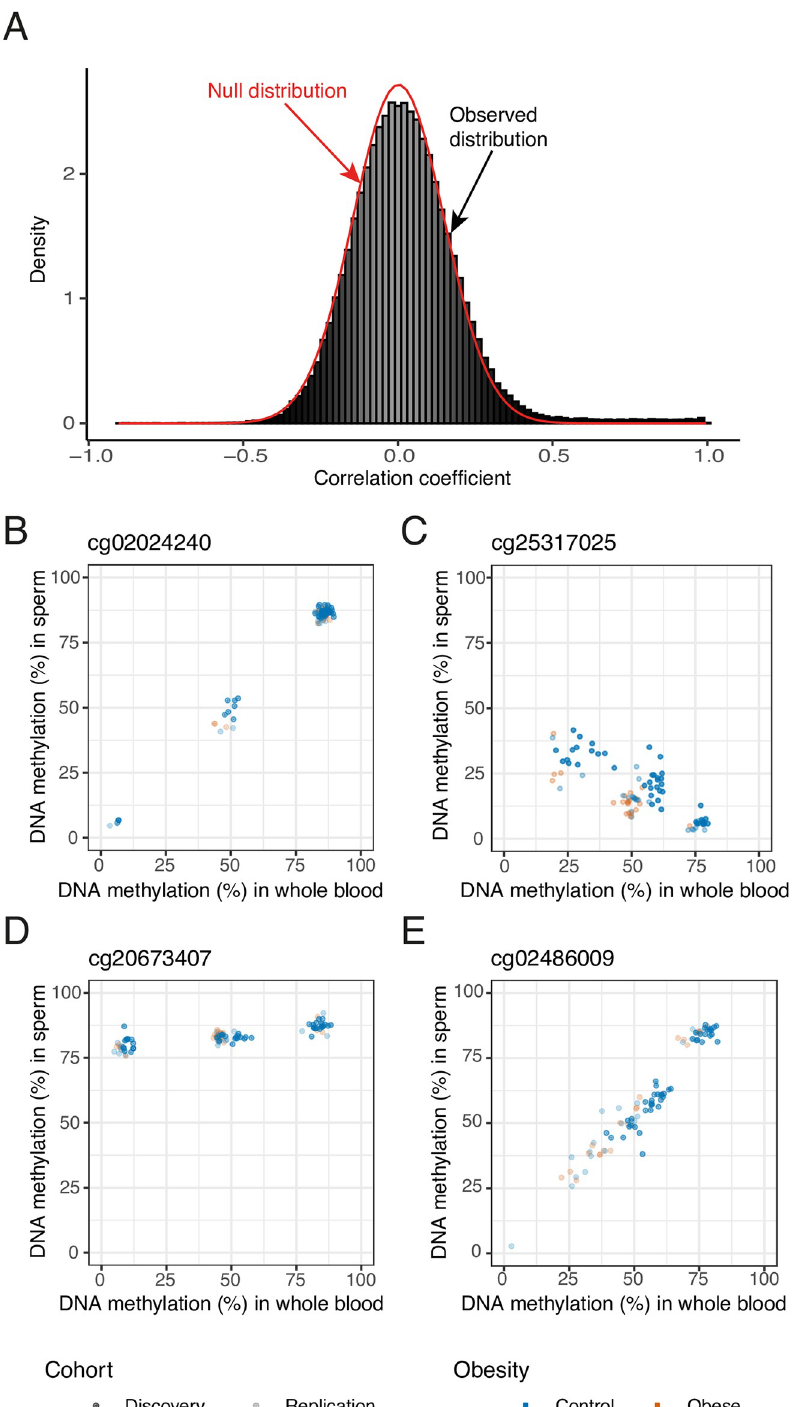
Fig 4. Covariation of DNA methylation between blood and sperm. ( A ) The observed correlation of DNA methylation levels in sperm and blood (histogram) is plotted against the estimated null distribution (red density curve). A small percentage of sites display highly correlated DNA methylation levels ( r > 0.8), and the observed distribution is overall slightly shifted to the right compared to the null distribution. ( B ) cg02024240 (chr5:159669974) shows a strong DNA methylation correlation between blood and sperm and a trimodal methylation pattern suggestive of a genetically driven effect ( r > 0.99, P = 4.68 × 10 − 48 ). ( C ) cg25317025 (chr18:47019823) is one of 30 sites showing a